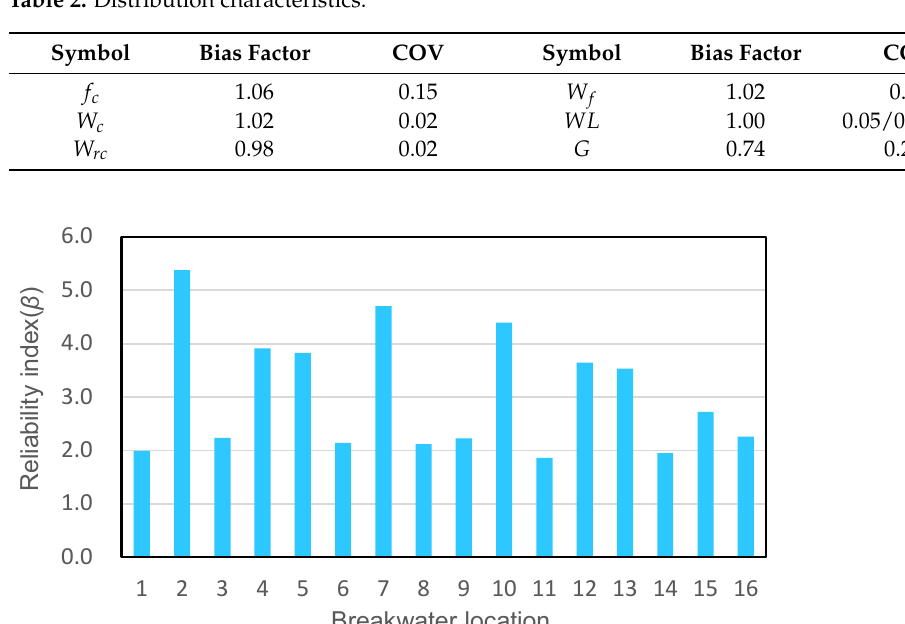
Figure 5. Sensitivities of limit state function (sliding). 5. Code Calibration Using the sensitivity coefficient ( 𝛼 (cid:3025) ) and target reliability index ( 𝛽 (cid:3021) ) , the partial safety factor can be obtained for each random variable by the following formula [4]. 𝛾 (cid:3025) = (1 − 𝛼 (cid:3025) 𝛽 (cid:3021) 𝜎 (cid:3025) ) 𝜇 (cid:3025) 𝑋 (cid:3038)